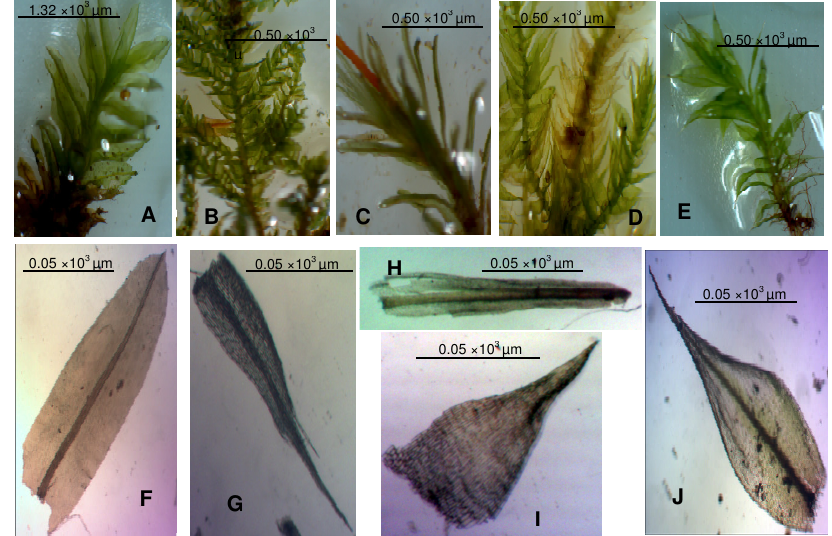
Fig. 1. Gametophytic morphological features of the moss species studied. A: Hyophila crenulata shoot ; B: Thuidium gratum shoot; C: Barbula lambarenensis shoot; D: Stereophyllum nitense shoot E: Bryum coronatum shoot; F: Hyophila crenulata perichaetial leaf ; G: Thuidium gratum perichaetial leaf; H: Barbula lambarenensis perichaetial leaf; I: Stereophyllum nitense perichaetial leaf; J: Bryum coronatum perichaetial leaf